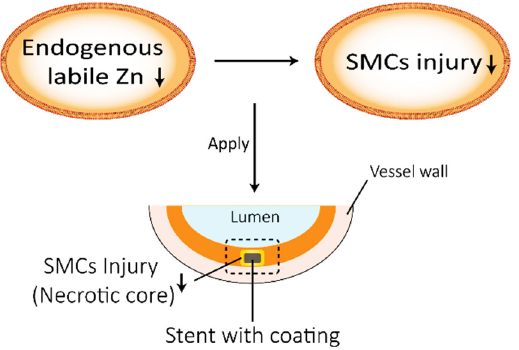
Figure 1. Schematic illustration showing the potential relationship between endogenous labile Zn and cell injury and its potential application in stents (SMCs, smooth muscle